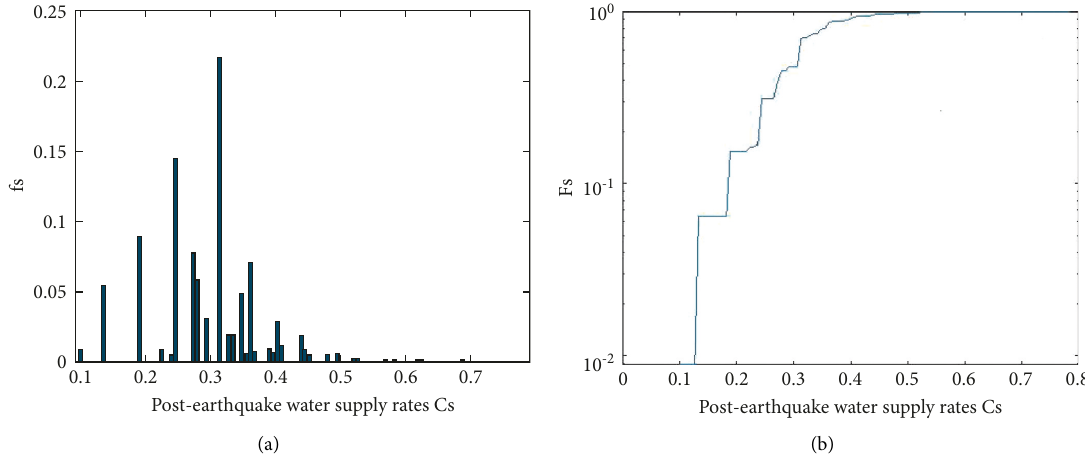
Figure 6: Post-earthquake water supplyrate (cast iron pipe) with severity liquefactionof intensity X. (a) Probability massfunction. (b) Cumulative distribution function.